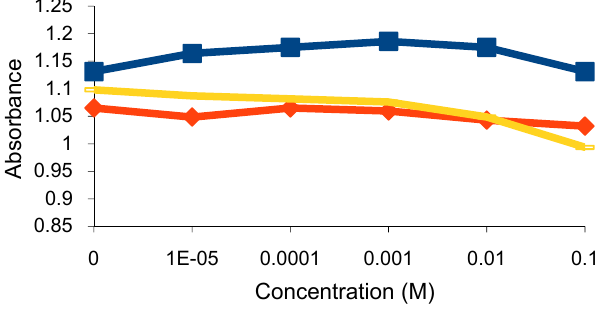
Figure 4. Turbidity absorbance of sensing element vs. concentration of Cu 2+ ( ), Cd 2+ ( ) and Pb 2+ ( ) ions.